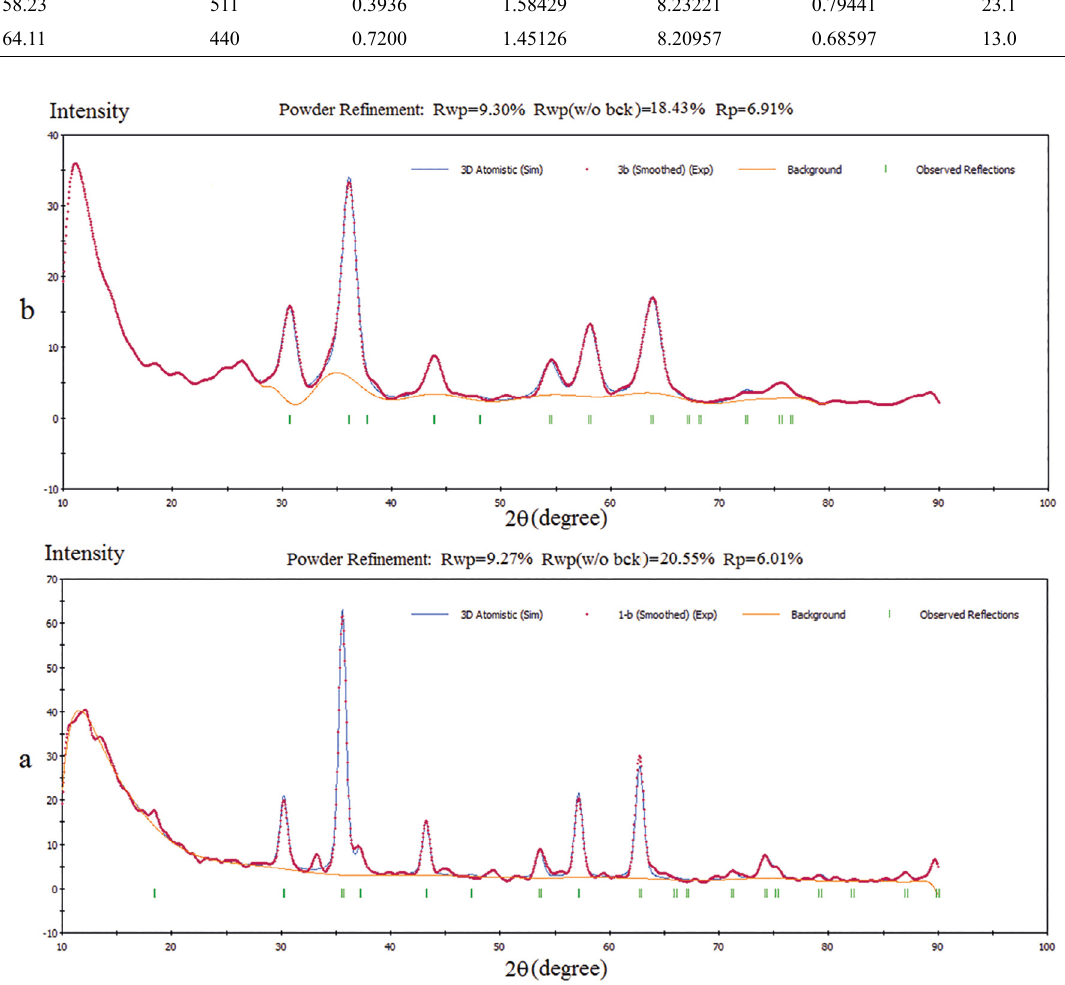
O , b: Al CoFe O 2 4 0.44 1.56 4